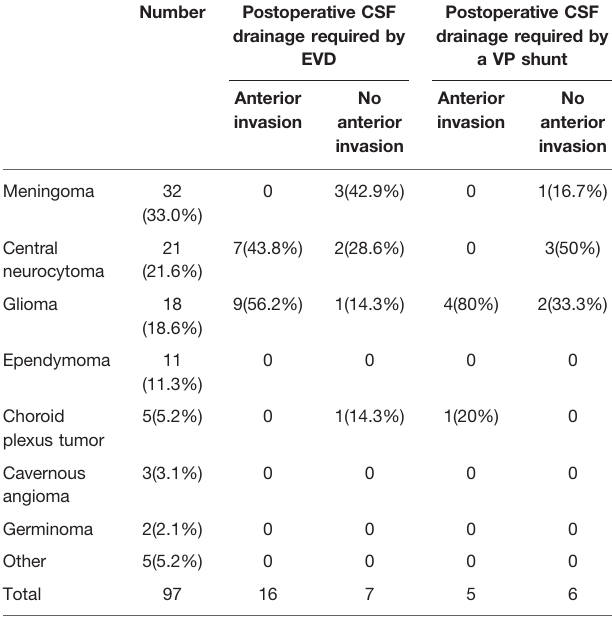
TABLE 1 | Location and histological characters of LVTs with postoperative CSF